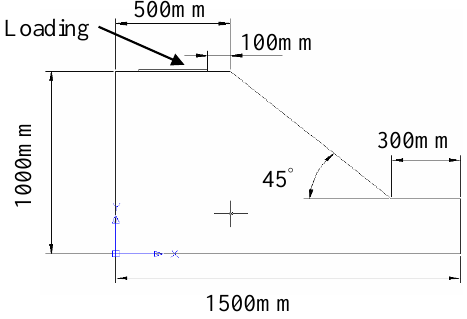
Figure 1 Locations of transducers Figure 2 Section view of soil slope model Figure 2. Section view of soil slope